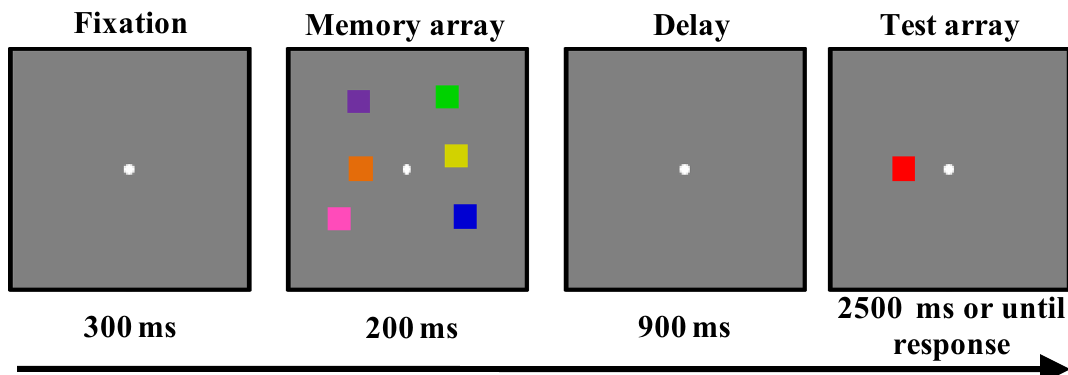
Figure 1. The task structure for the VWM capacity